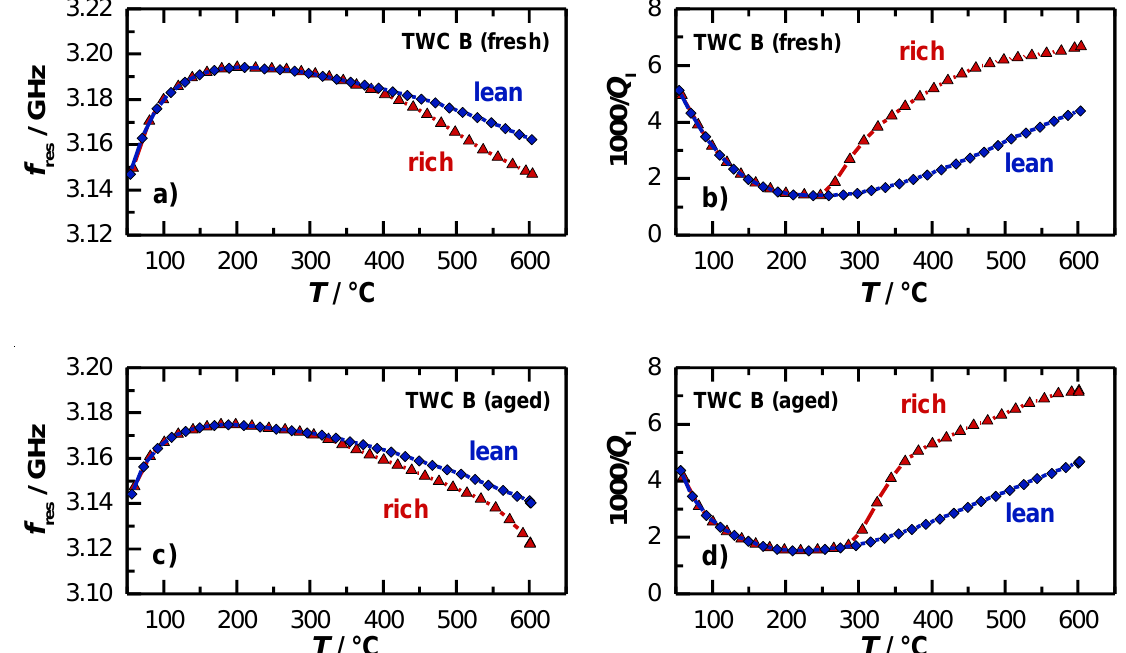
Figure 7. Radio frequency-derived signals as a function of the catalyst temperature during light-off experiments: ( a ) Resonant frequency and ( b ) inverse loaded quality factor for an oxidized and reduced TWC (fresh); ( c ) resonant frequency and ( d ) inverse loaded quality factor for an oxidized and reduced TWC (aged).